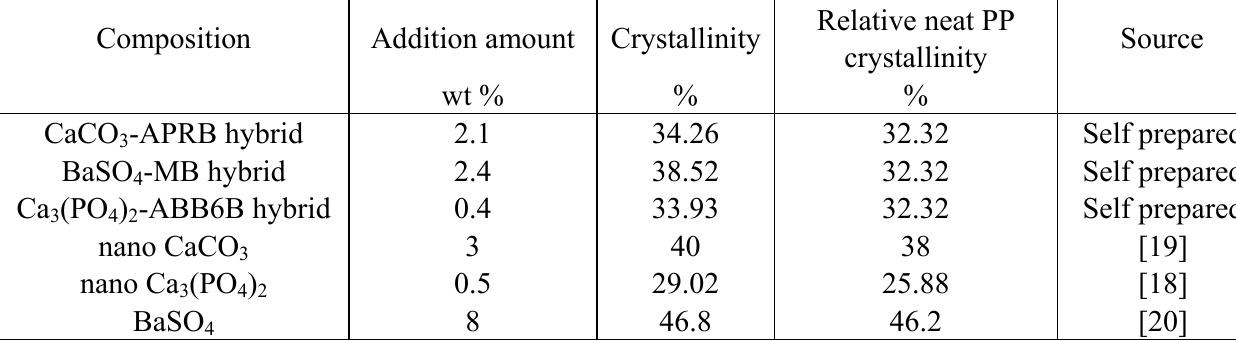
Table 1. Crystallinity for different compositions in